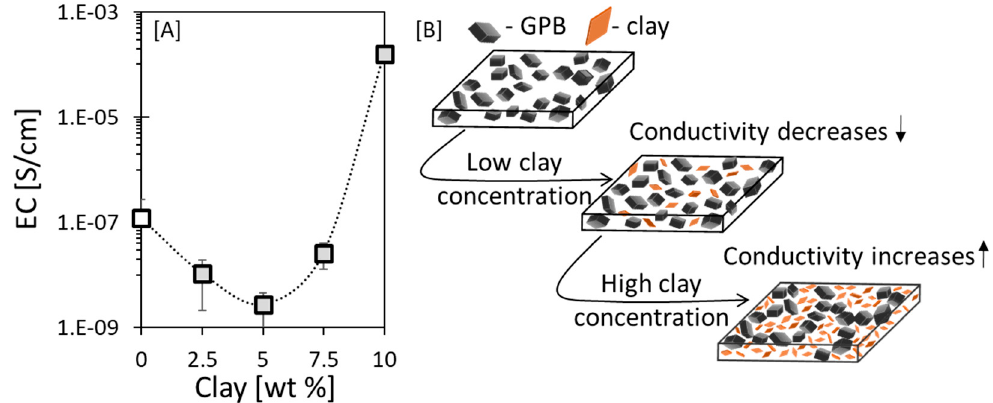
Figure 6. ( A ) Clay concentration-induced change in the EC of a GPB-thickened oil system measured immediately after preparation with a fixed GPB concentration of 25 wt%. The dotted lines are drawn as guidance for the eye. ( B ) Schematic representation of thickened linseed oil (white) loaded with GPB (black) and clay (orange). At low clay concentration, the EC decreased since the nonconductive clay particles impeded the formation of conductive network. At higher clay concentration the EC increases due to excluded volume effect forcing the conductive GPB fillers to percolate.